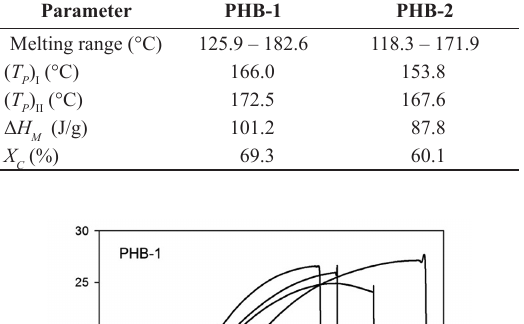
Table 1. Melting parameters of PHB-1 and PHB-2 determined during heating at 10 °C/min. Parameter